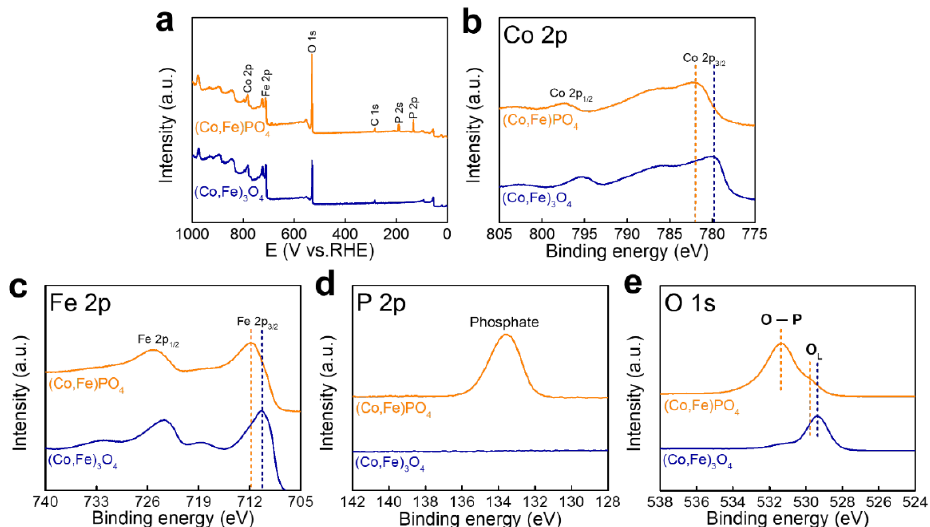
Figure 3. Analyses of the chemical states. ( a ) Full XPS survey spectra of (Co,Fe) 3 O 4 and (Co,Fe)PO 4 , ( b ) Co 2p, ( c ) Fe 2p, ( d ) P 2p, and ( e ) O 1s. LSV was performed to measure the HER activity in a 1 M KOH solution (Figure